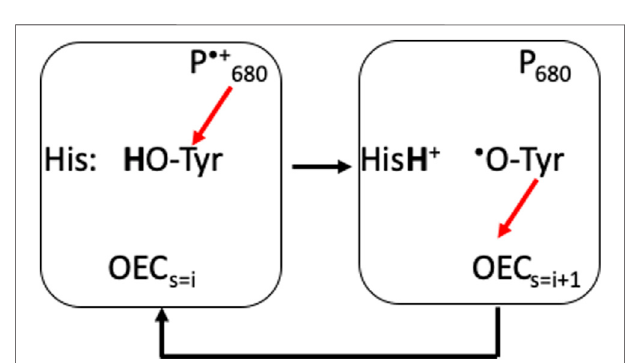
FIGURE 5 | D1-His 190 is an example of a PLS supporting transient redox cycling of Y Z (D1-Tyr 161), which is an intermediate electron donor/ acceptor in the PSII electron transfer chain. Red arrows show electron (cid:129) + ( ≈ 11 Å away) transfers. Y Z is an electron donor to the oxidized P 680 and acceptor from the OEC ( ≈ 5 Å away). The pK a of the oxidized Tyr is < 0, while it is 9.8 when it is reduced. His 190 ensures that the proton is captured when the Tyr is oxidized and returned when the Tyr is reduced. As Y Z and His 190 are hydrogen bonded together, the proton simply moves between the two residues and does not escape (Ishikita and Saito,